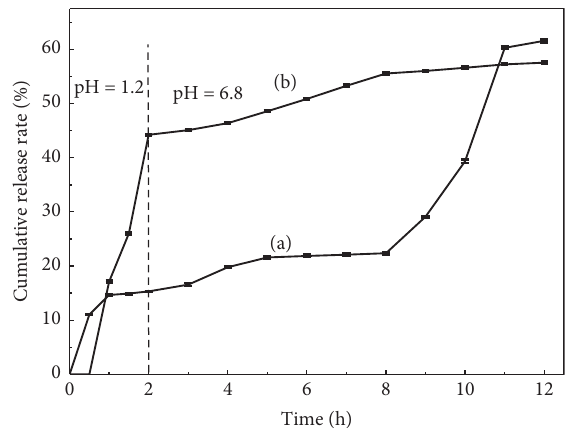
Figure 8: Cumulative release profiles of the CS/SA/chitosan composite nanoparticles prepared with a weight ratio of SA to CS of (a) 2:1 and (b) 1:1; SA to chitosan and SA to calcium chloride of 1: 1 and 3:17, respectively, in simulated gastric (pH=1.2) and in- testinal (pH=6.8) media at 37 °